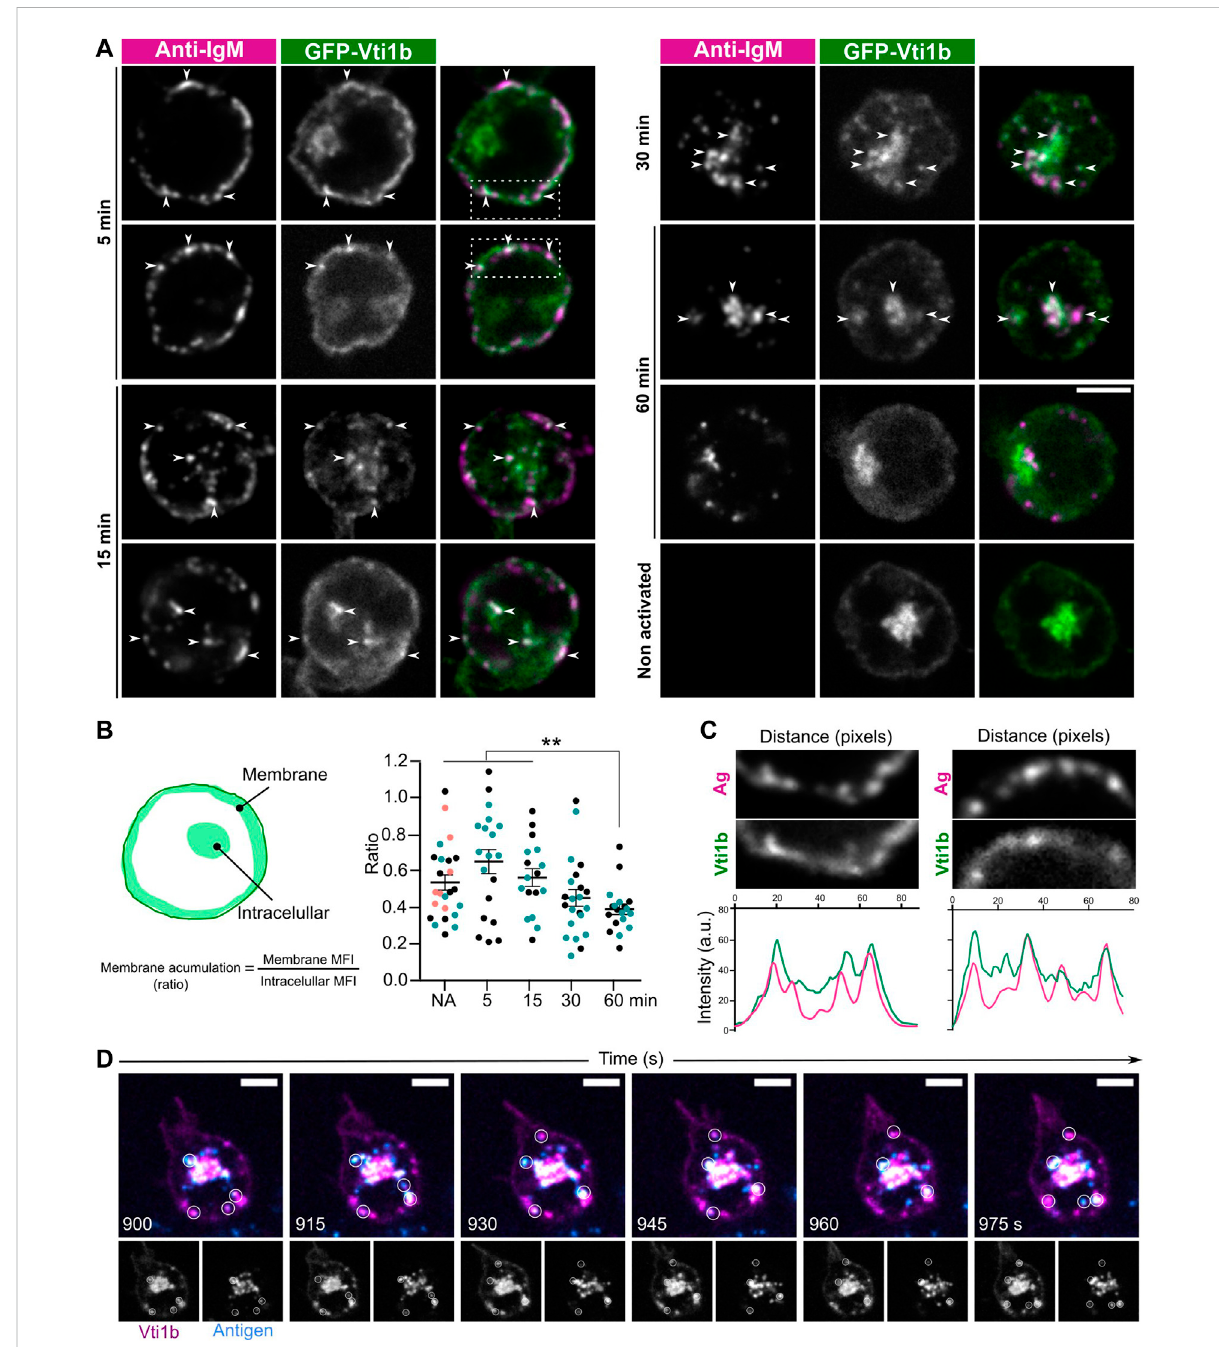
FIGURE 2 Vti1bpartiallycolocalizeswithantigenattheplasmamembraneandintheendosomalpathway. (A) GFP-Vti1b(green)transfectedA20D1.3cells were activated (5 – 60 min) or not (non-activated) with anti-IgM F (ab ’ )2 fragments as a surrogate antigen (magenta), fi xed, and imaged using a spinning diskconfocalmicroscope.Scale bar:5 µm.Representative images(2D, oneplane) are shown ( n = 2 – 3independentexperiments). (B) Non- activated (NA) or activated (5 – 60 min) GFP-Vti1b transfected cells were analysed using Fiji ImageJ. The MFI of GFP-Vti1b (membrane and intracellular; see schematics) was obtained and the ratio was calculated to analyse the membrane enrichment of Vti1b before and after activation. Every dot represents one cell; each colour represents one independent experiment ( n = 2 – 3 experiments). (C) Plot pro fi le analysis showing colocalisationofthesurrogateantigenanti-IgM(Ag)andVti1bontheplasmamembrane.Theinsetcorrespondstothedottedsquareinimage2A. (D) LiveimagingofVti1b-GFP(magenta)vesiclestogetherwithinternalisedantigenvesicles(cyan).FramesfromSupplementaryMovieS1.Oneframehas been selected every 15 s. The white circles show examples of colocalisation. Scale bar: 5 μ